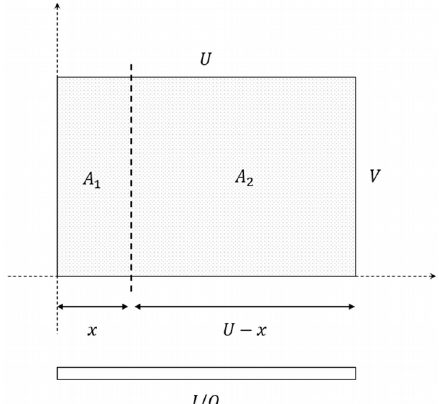
Figure 2. Warehouse layout and random variable